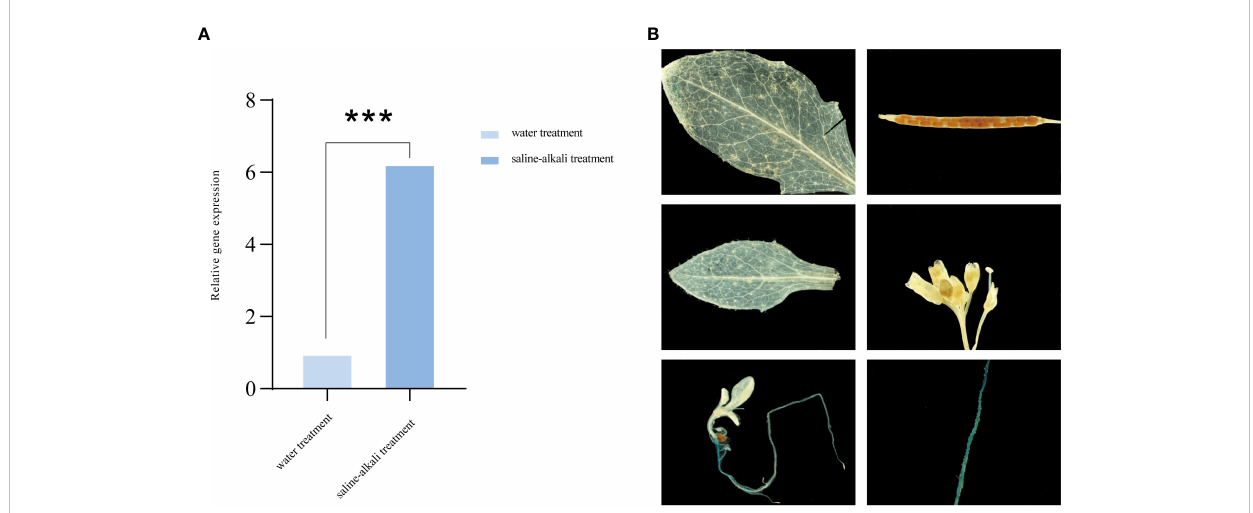
FIGURE 1 Expression pattern analysis of AhALDH3H1. (A) AhALDH3H1 expression level in Arachis hypogaea ; (B) Tissue-speci fi c activity of the AhALDH3H1 promoter in transgenic Arabidopsis thaliana . Three biological replicates were used. Data was calculated using the 2 − DD CT method. Statistical analysis was performed using t -test ( P < 0.05), * P < 0.05, ** P < 0.01, *** P < 0.001, and **** P <